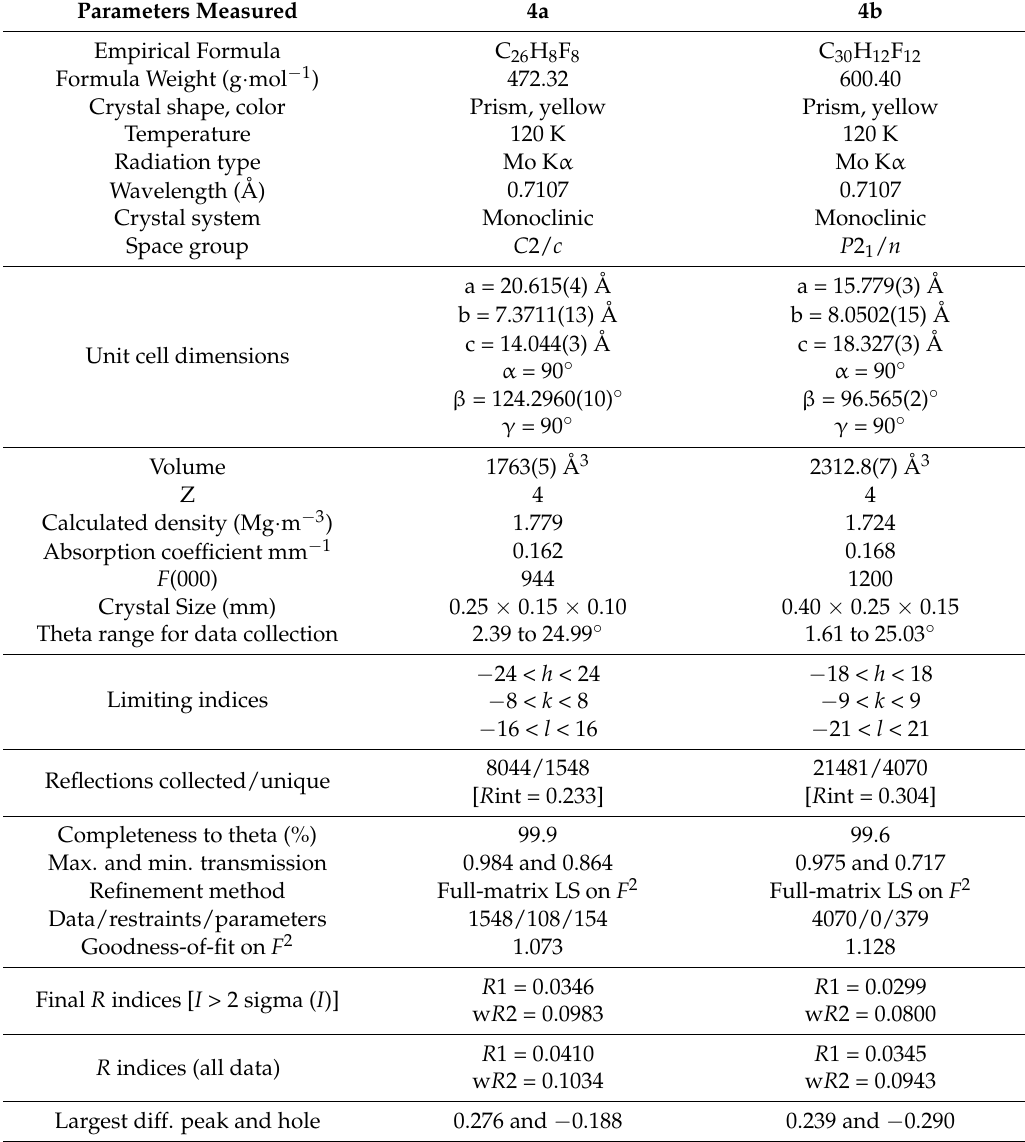
Table 3. Crystal data and structure refinements for 4a and